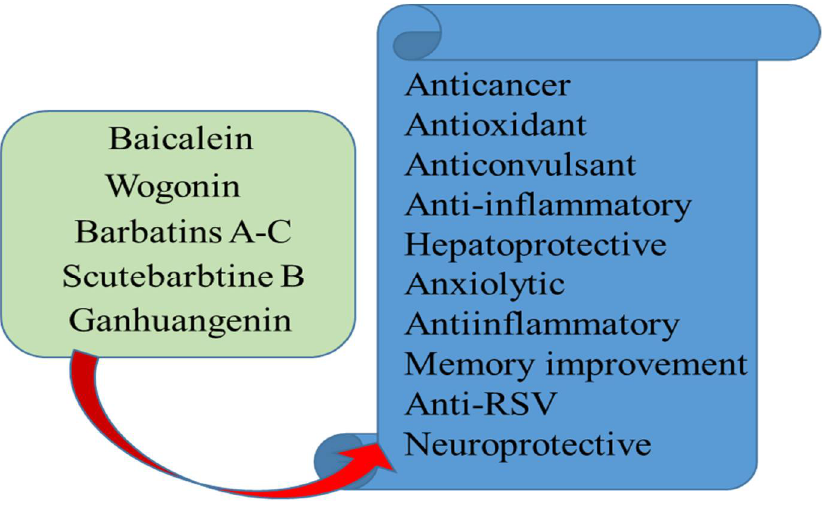
Figure 6. Medicinal uses of the major compounds isolated from Scutellaria